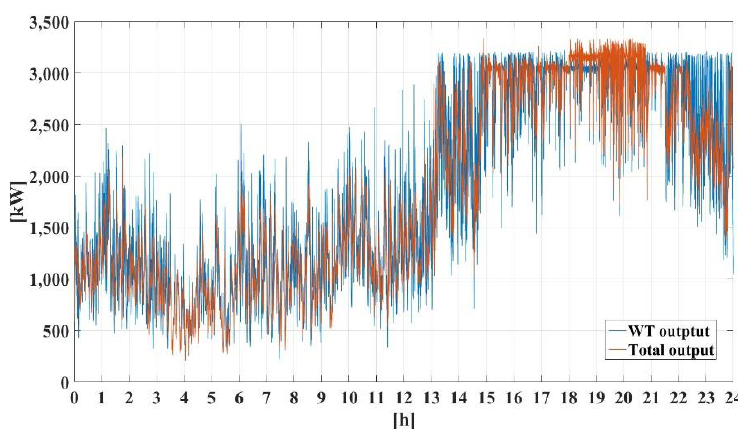
Figure 15. Field test result 2: SOC of ESS.